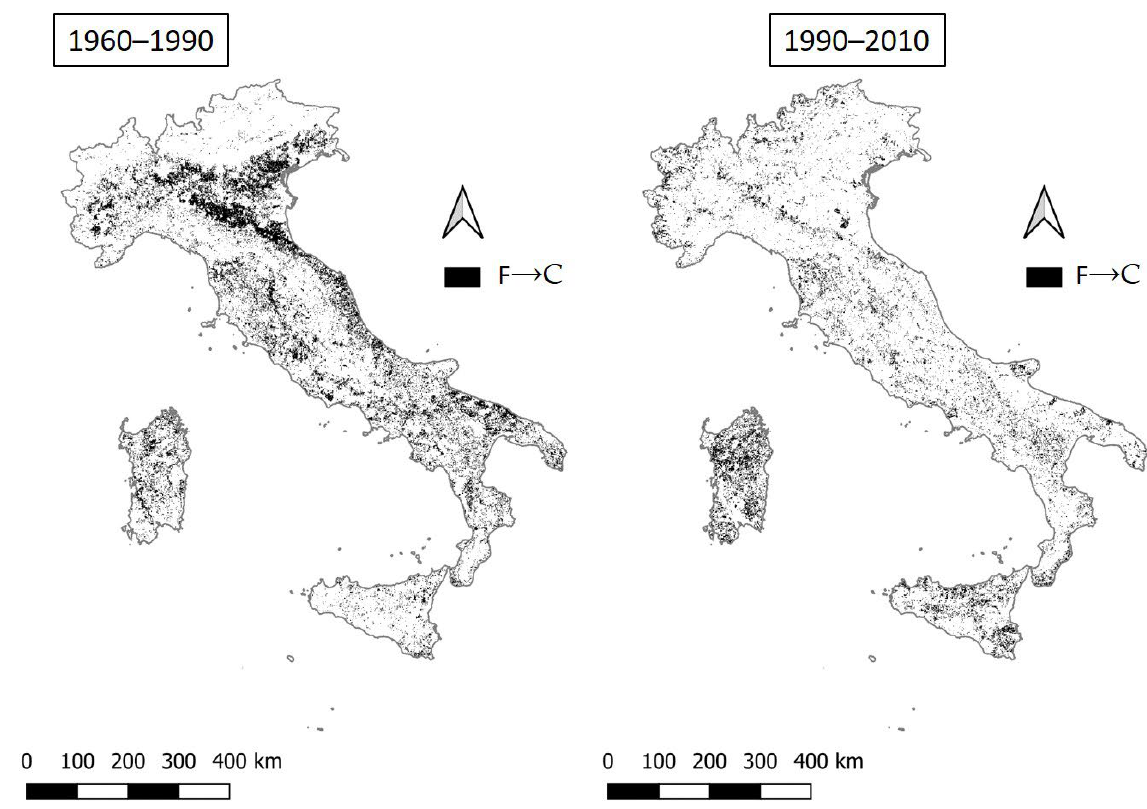
Figure 5. The transition from fragile to critical areas (F → C) in the two time intervals 1960–1990 and 1990–2010. For both periods, the transition from non-vulnerable areas to critical areas is very rare, featuring a jump of two classes, which represents a significant worsening of environmental conditions (Figure 6). Worse conditions predisposed to land degradation are more scattered across the national territory, consolidating hot-spots of variable size, namely, few pixels of a few square kilometers, experiencing a sort of ‘pulsation’. Reversing this pattern implies policies that cannot act exclusively on a national or regional scale, but requires monitoring strategies that increasingly focus on the local scale.